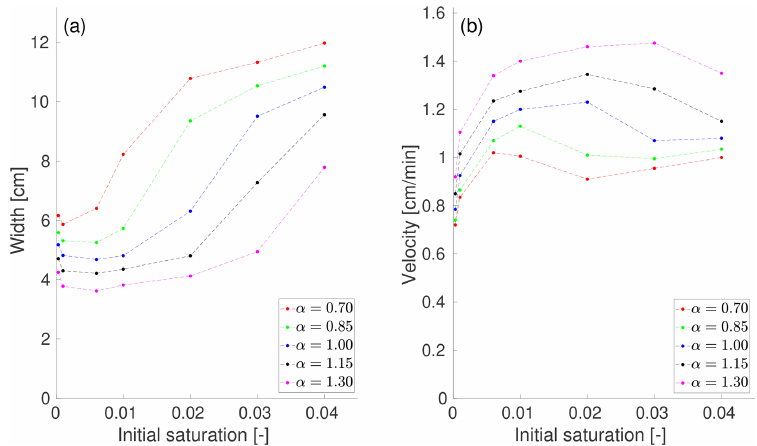
Figure B4. The effect of the retention curve on the flow regime. The width (a) and the velocity (b) of the finger (or wetting front) at t = 25min is plotted against the initial saturation for five different values of parameter α . The averages of four different distributions of the intrinsic permeability are plotted.